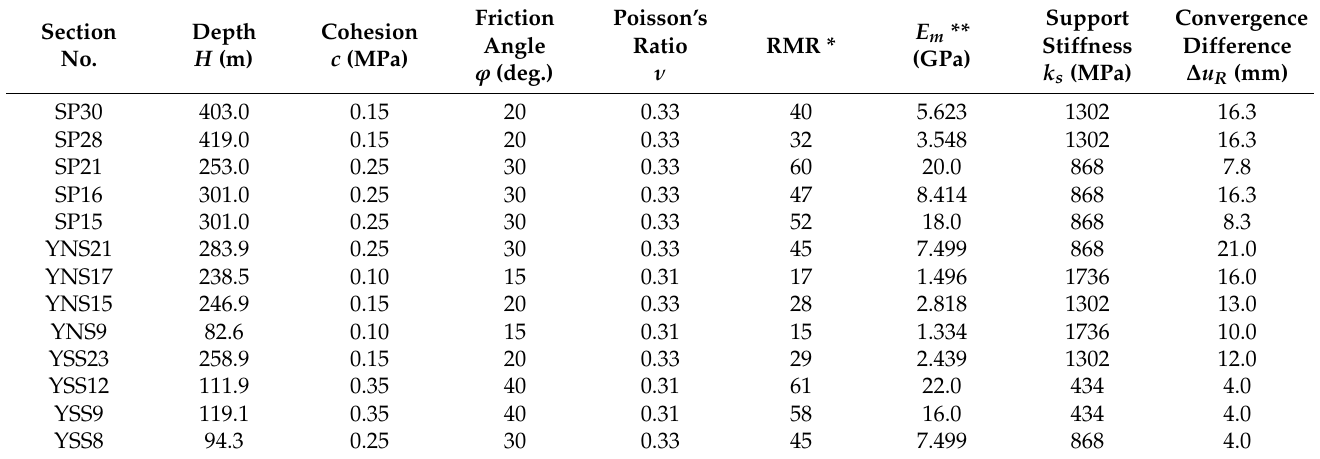
Table 7. Parameters of the observation in part of the 68 sections in two railway